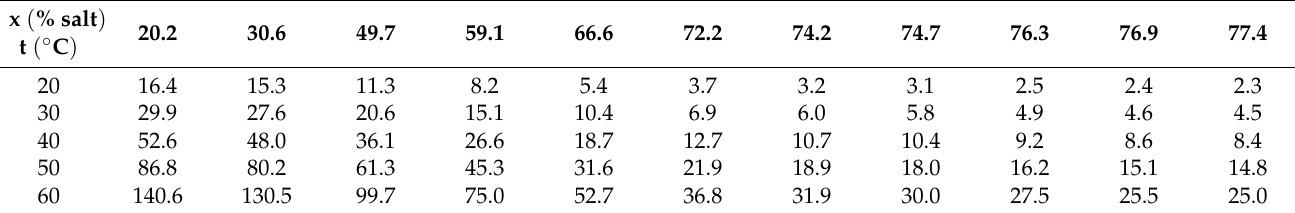
Table A29. Coefficients of the H 2 O-Ca(NO 3 ) 2 saturated pressure equation.